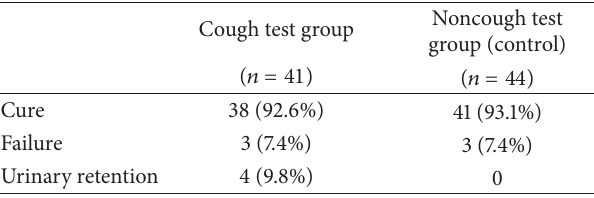
Table 2: Outcome of TVT in cough and noncough